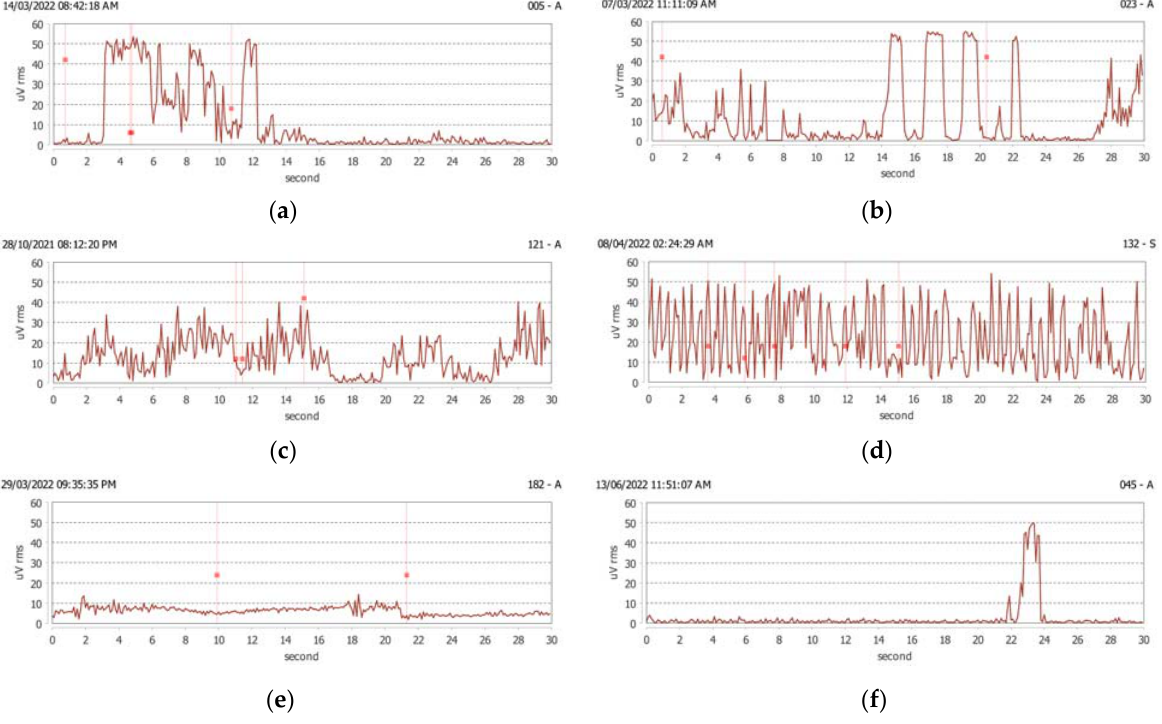
Figure 1. sEMG events (expressed by root–mean–square voltage at a specific moment of time): ( a ) tonic contraction, ( b ) rhythmic or phasic contraction, ( c ) light grinding or rubbing of the teeth, ( d ) severe grinding, ( e ) mandibular clenching, and ( f ) pushing the mandible. Rhythmic or phasic contraction —EMG of the masseter muscle showed rhythmic